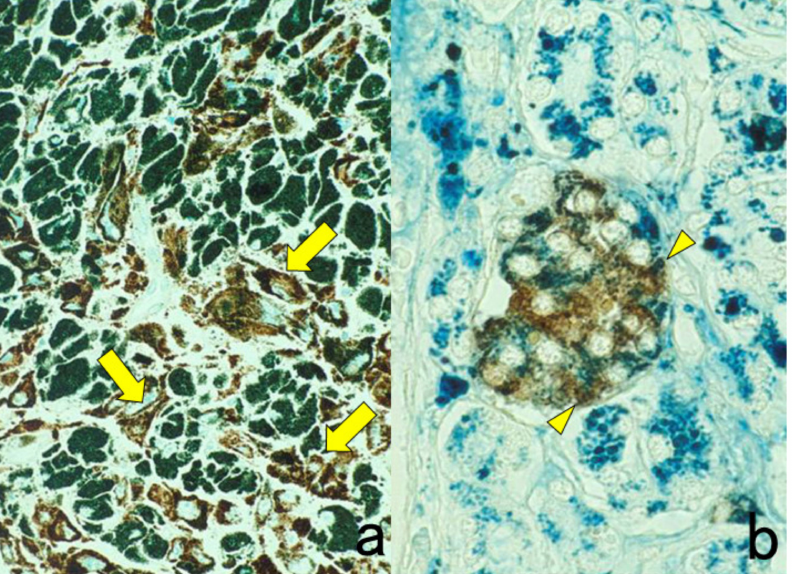
Figure 21. Metachromasia of melanin by methyl green counterstaining in heavily pigmented nasal malignant melanoma ( a ) immunostaining for HMB45 and Berlin blue counterstaining for hemosiderin in pancreatic hemochromatosis ( b ) immunostaining for insulin. Brown-colored pigments such as melanin and hemosiderin hamper the judgment of DAB coloration. Counterstaining with methyl green and Berlin blue is quite effective for distinguishing the DAB color from the endogenous pigments. The rich distribution of HMB45-negative metachromatic melanophages is noted in panel ( a ). Arrows indicate HMB45-positive melanoma cells. In panel ( b ), hemosiderin deposition is observed in insulin-positive β -cells of the pancreatic islet (arrowheads).